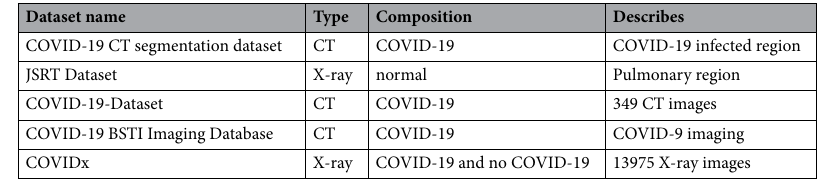
Table 4. COVID-19 related